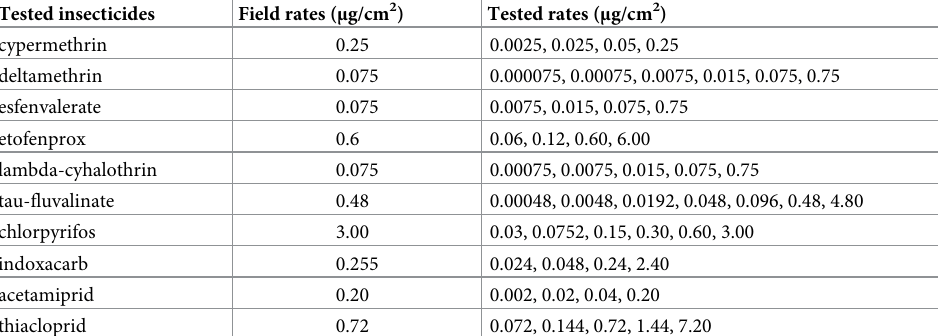
Table 1. The recommended field rates and tested rates of insecticides used to evaluate CSFB susceptibility from the Prague and Poteˇhy localities in 2015–2018. Tested insecticides